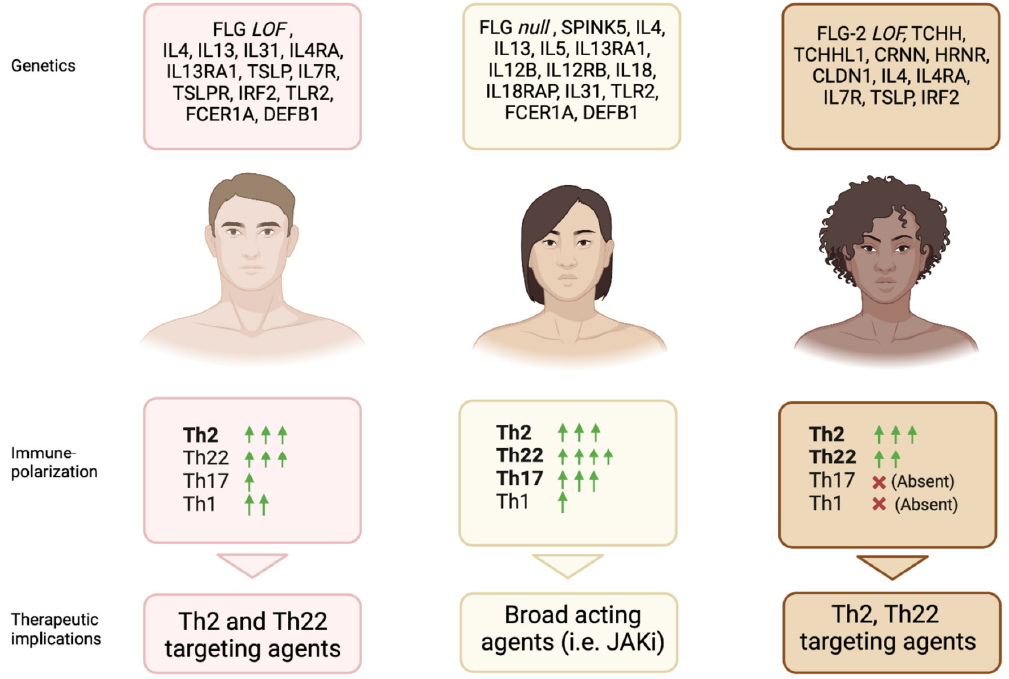
Figure 1. Main genetic, clinical, and immunological features in AD patients across ethnicities. Predominant genetic features of each subgroup, immune-polarization, and potential therapeutic implications are shown. FLG: Filaggrin; LOF: Loss-of-function; IL: Interleukin; TSLP: Thymic stromal lymphopoietin; IRF2: Interferon regulatory factor 2; TLR2: Toll-like receptor 2; FCER1A: Fc ε Receptor1 α ; DEFB1: B -Defensin 1; SPINK5: Serine Peptidase Inhibitor Kazal Type 5; TCHH: Trichohyalin; TCHHL1: Trichohyalin like 1; CRNN: Cornulin; HRNR: Hornerin; CLDN1: Claudin 1; Th: T helper; JAKi: JAK inhibitors. Created with BioRender.com